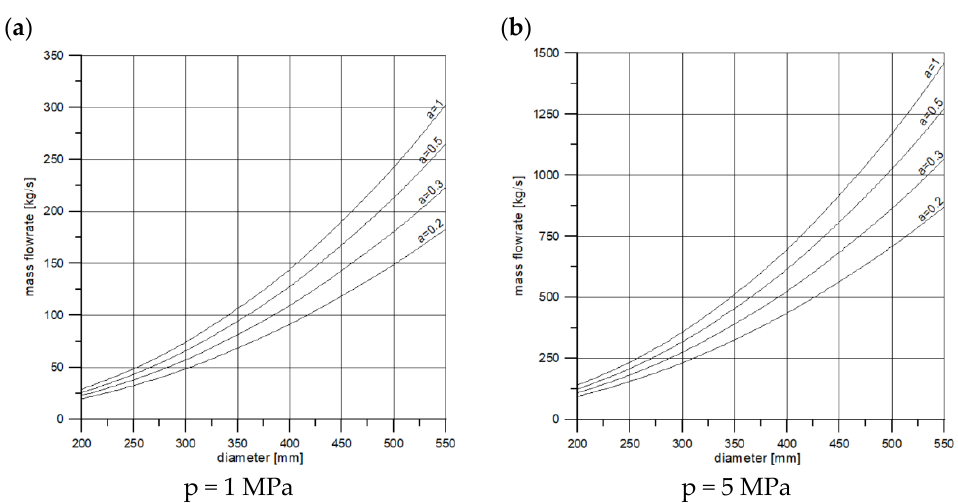
Figure 15. Mass flow through the hole (puncture/rupture) in the pipeline for various gas pressures in the pipeline: ( a ) p = 1 MPa and ( b ) p = 5 MPa.